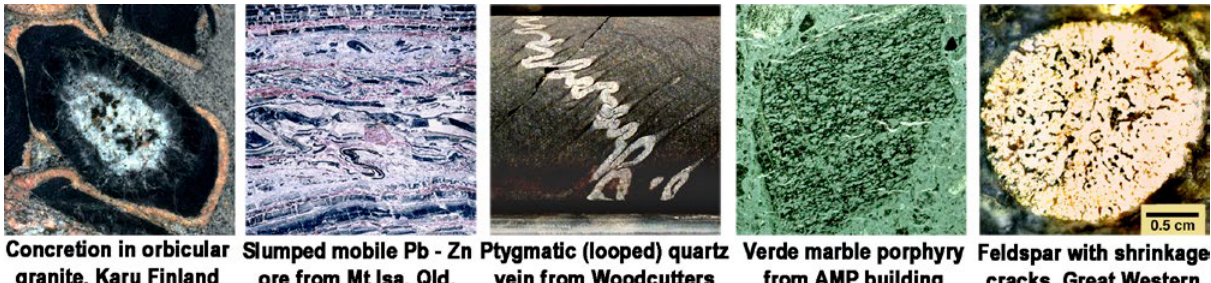
Figure 2. Five examples of the evidence that ancient sediments and mineral deposits contained or were comprised of colloidal